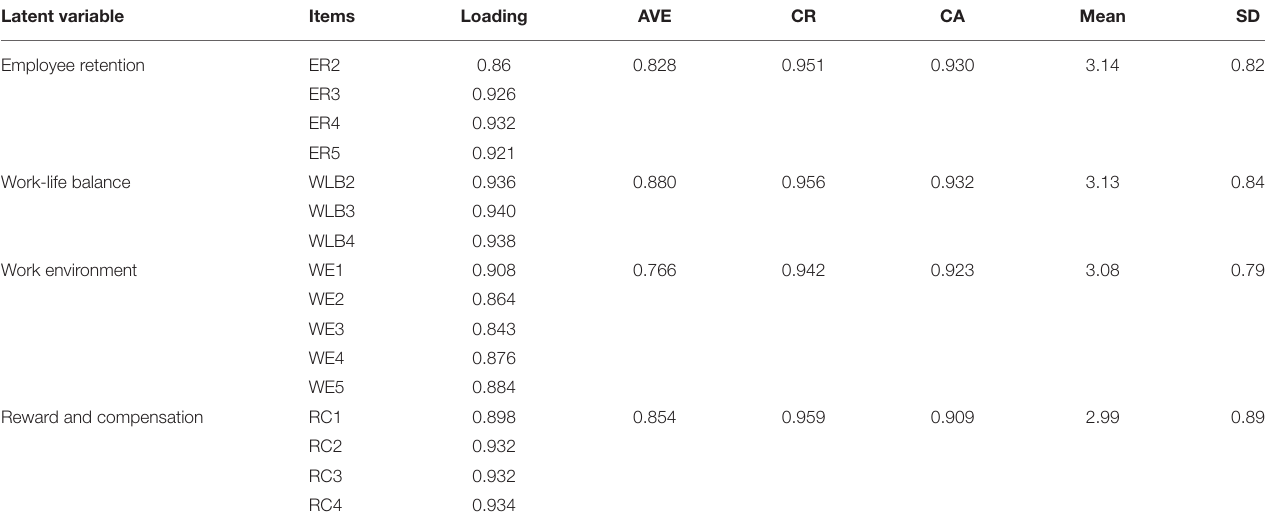
TABLE 2 | Results of measurement model assessment.